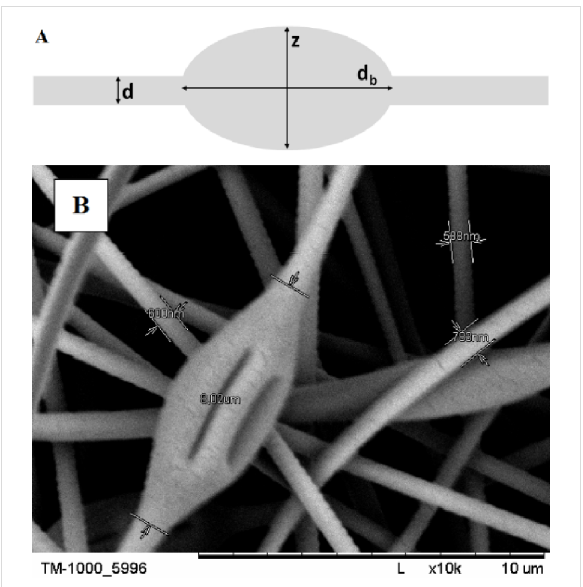
Figure 2: (A) A schematic of the measuring procedure of the size of beads and the diameter of the fiber (where z ≥ 3 d ). (B) An exemplary SEM micrograph of the obtained fibers and beads showing the mea- surement procedure (conditions: PVP 12%; 0.6 mL/h; 7.5